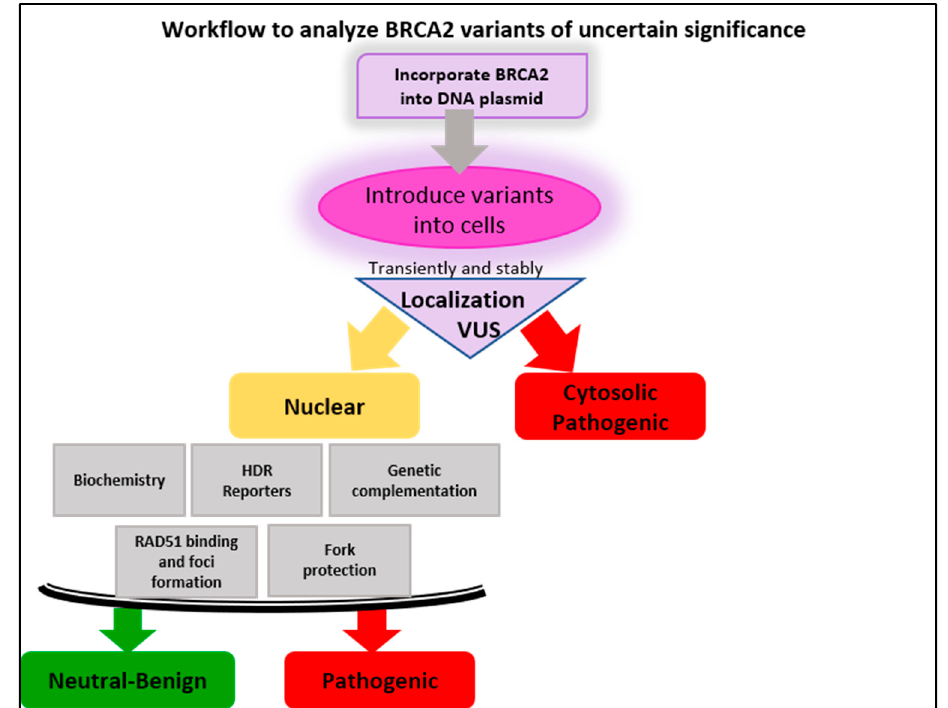
Figure 8. Workflow to analyze BRCA2 variants of uncertain significance.